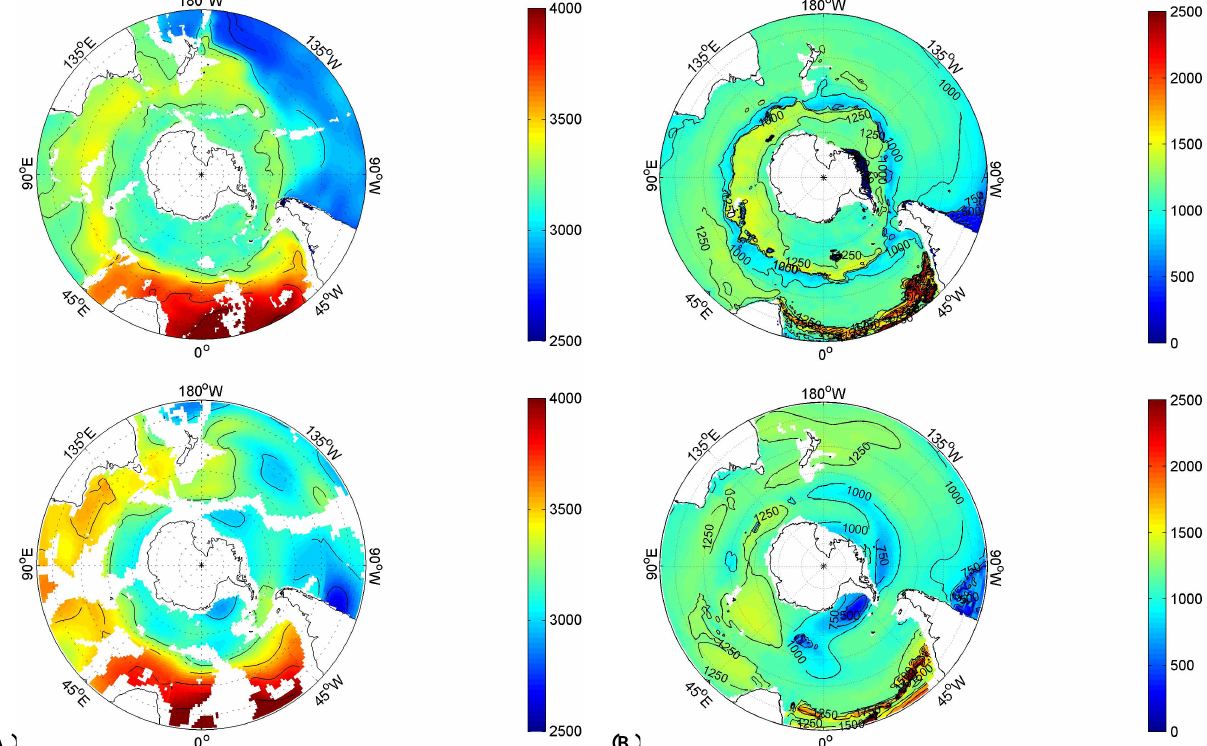
Fig. 8. (A) Depth of the CSH: the top figure is estimated from the CARS 2009 data (January), and bottom from GLODAP gridded data. (B) Depth of the ASH: the top is estimated from CARS 2009 data (January), bottom from the GLODAP gridded data. Contours are at 250m